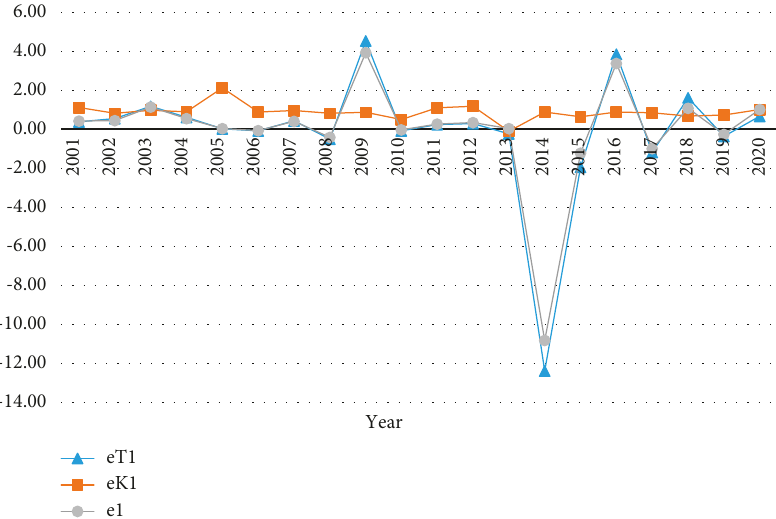
Figure 10: Relationship between carbon emission decoupling index and intermediate variables in coal sector from 2001 to